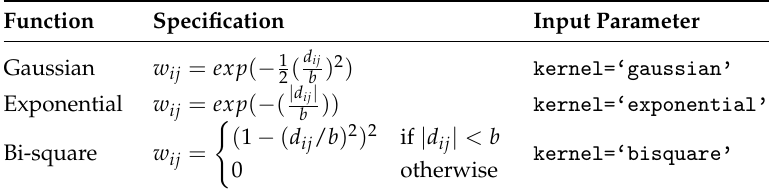
Table 3. Different kernel functions available to weight